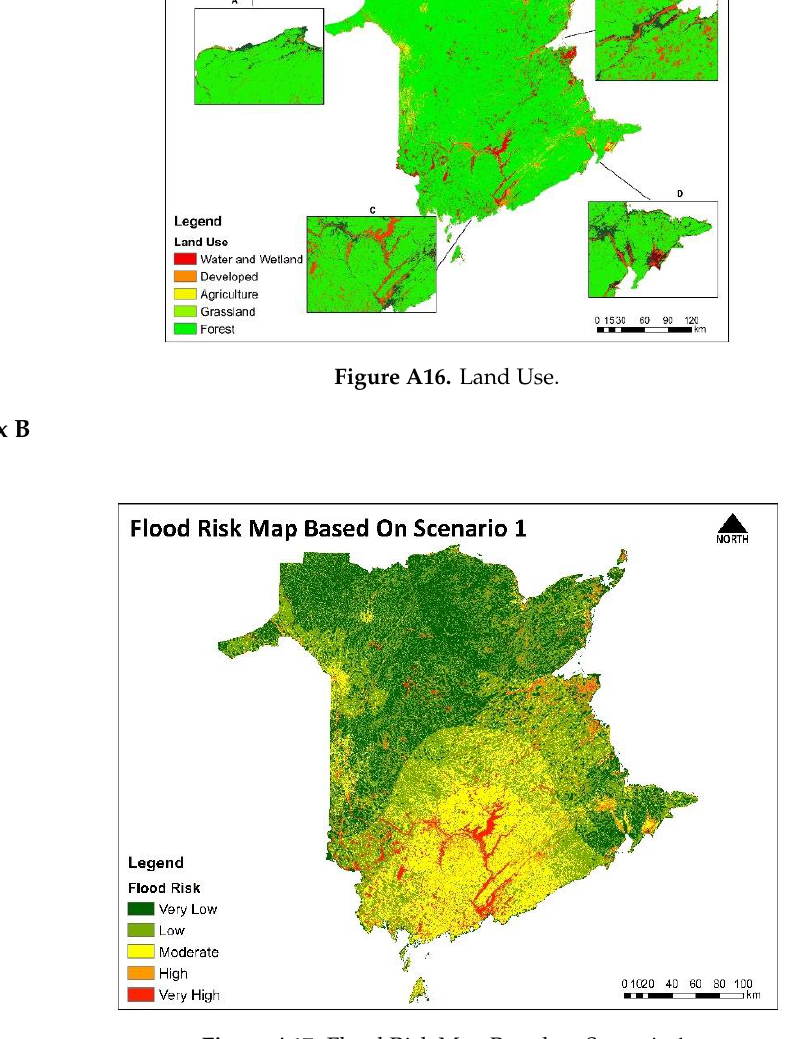
Figure A17. Flood Risk Map Based on Scenario 1.